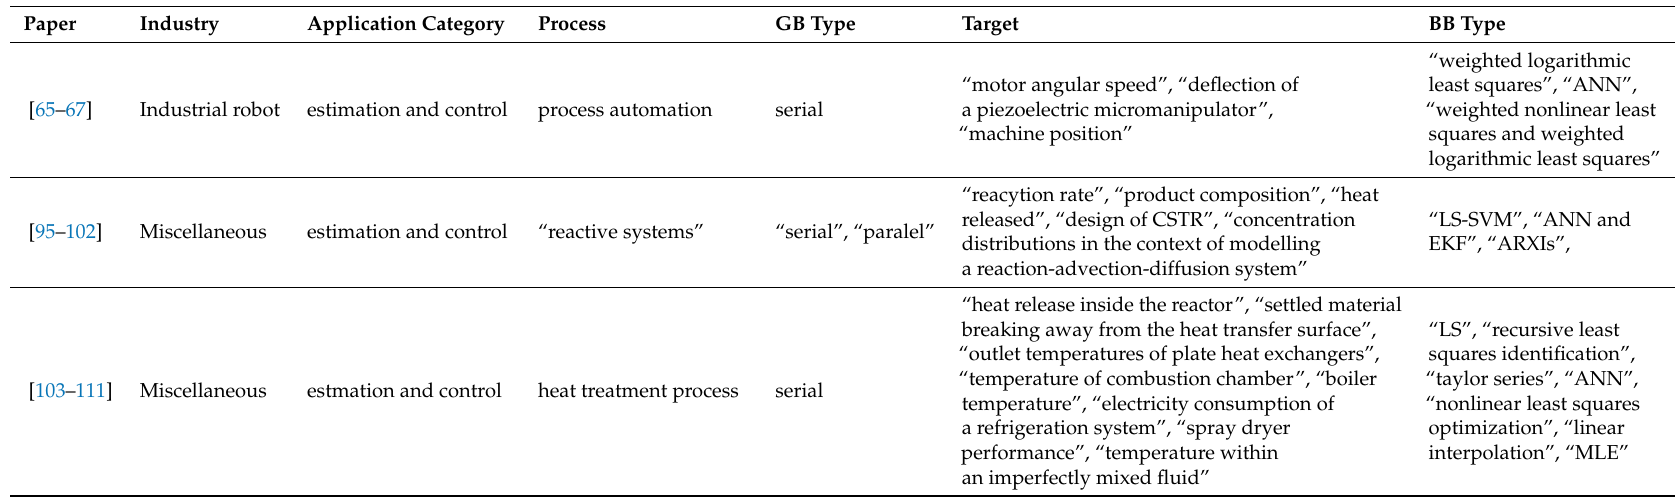
Table 3. GB modeling application in industrial robots and miscellaneous